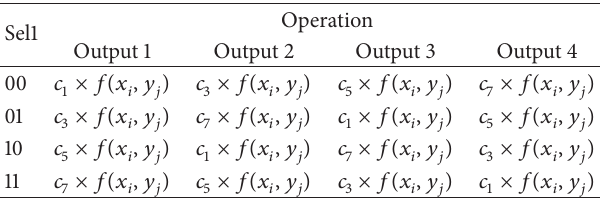
Table 3: Selector S1 attributes according to selection Sel1. Sel1